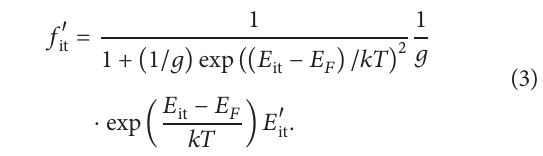
Figure 15: Five 𝐶 - 𝑉 curves of a single level ITs are plotted. Miller capacitance 𝐶 . (a) The trap is distributed at the energy level 0.6 eV above the midgap, (b) at the energy level 0.4 eV above the with variable ITs density 𝑁 it midgap, (c) at the midgap, (d) at the energy level 0.4 eV under the midgap, and (e) at the energy level 0.6 eV under the